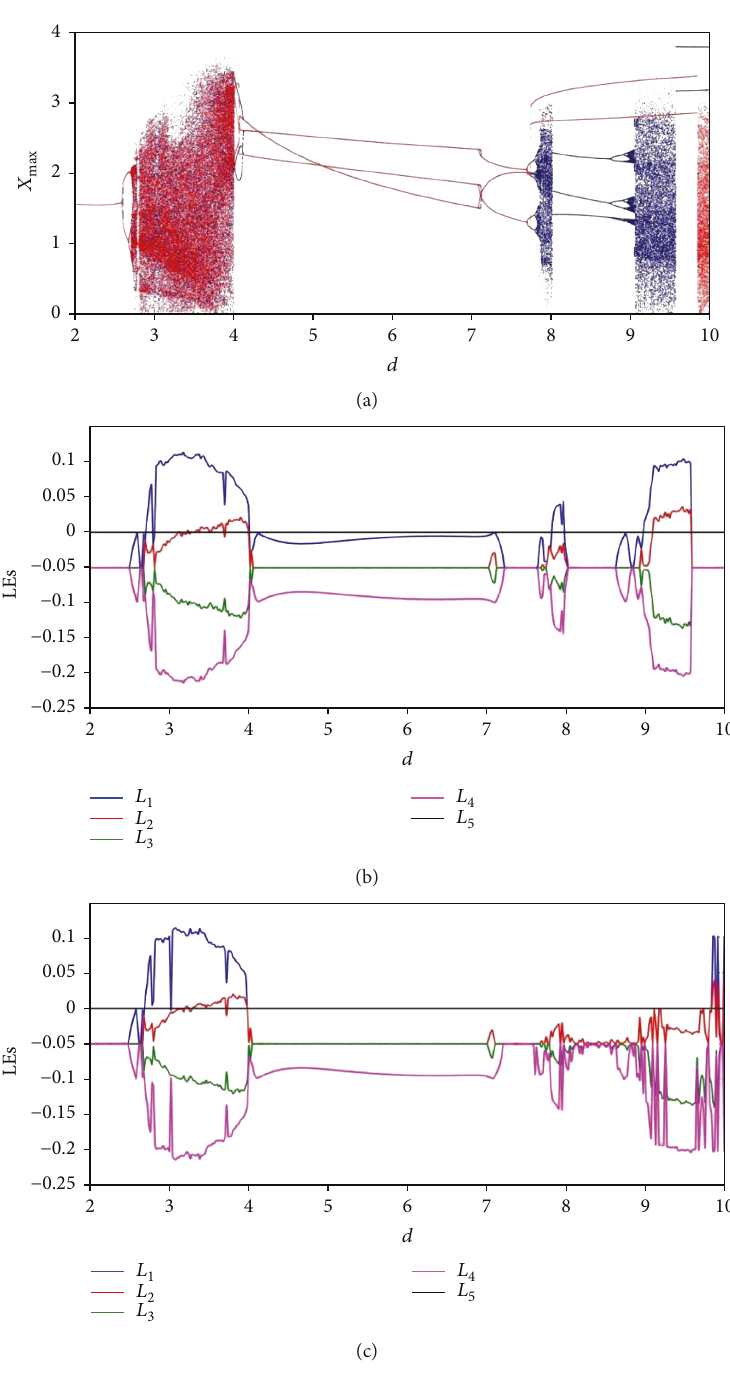
Figure 4: (a) Bifurcation plots of the FOPCC system with parameter d where the forward continuation is shown with blue dots and backward continuation is shown with red dots. The corresponding LEs are shown in (b) and (c) for forward and backward continuation,